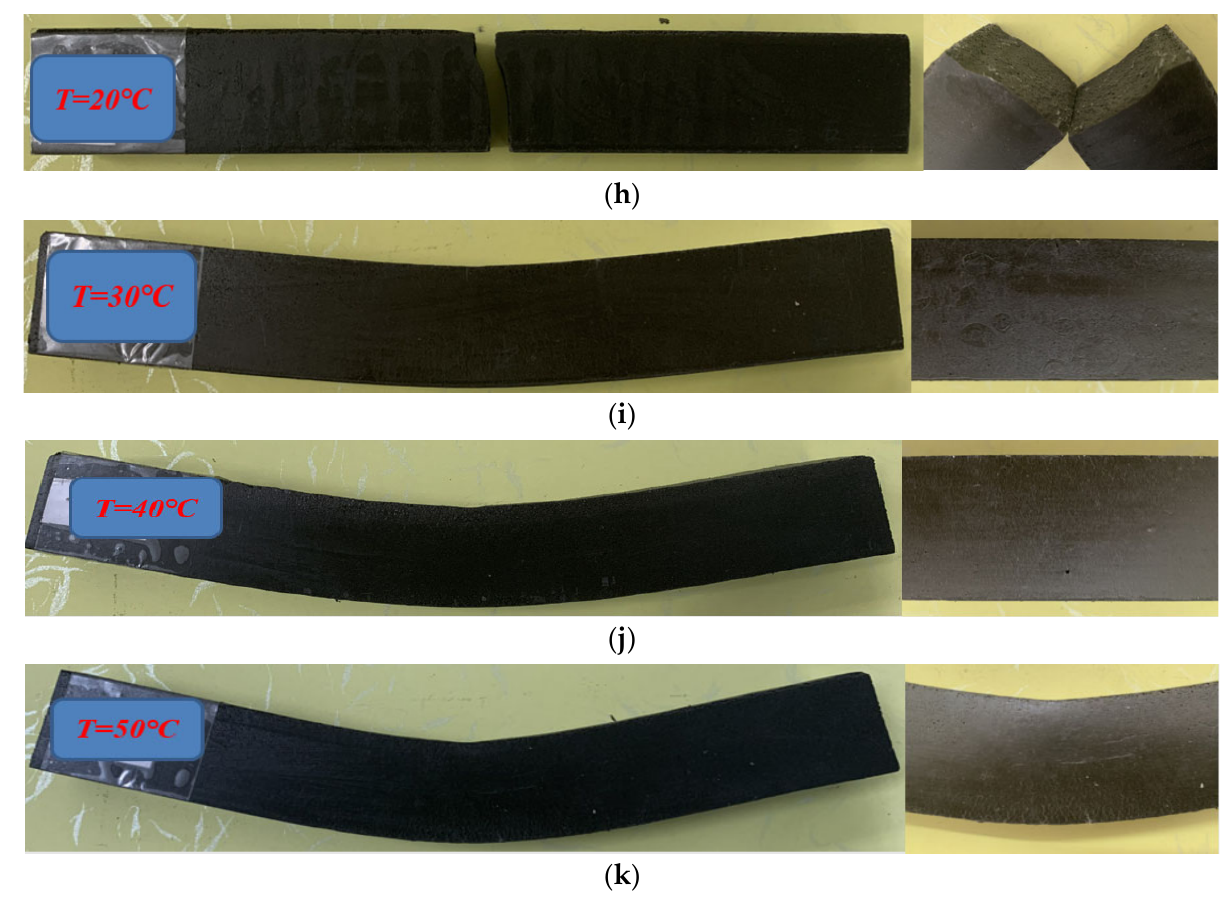
Figure 24. Failure forms of polyurethane cement trabeculae at different temperature levels: ( a ) Temperature T = − 50 °C; ( b ) Temperature T = − 40 °C; ( c ) Temperature T = − 30 °C; ( d ) Temperature T = − 20 °C; ( e ) Temperature T = − 10 °C; ( f ) Temperature T = 0 °C; ( g ) Temperature T = 10 °C; ( h ) Temperature T = 20 °C; ( i ) Temperature T = 30 °C; ( j ) Temperature T = 40 °C; ( k ) Temperature T = 50 °C.